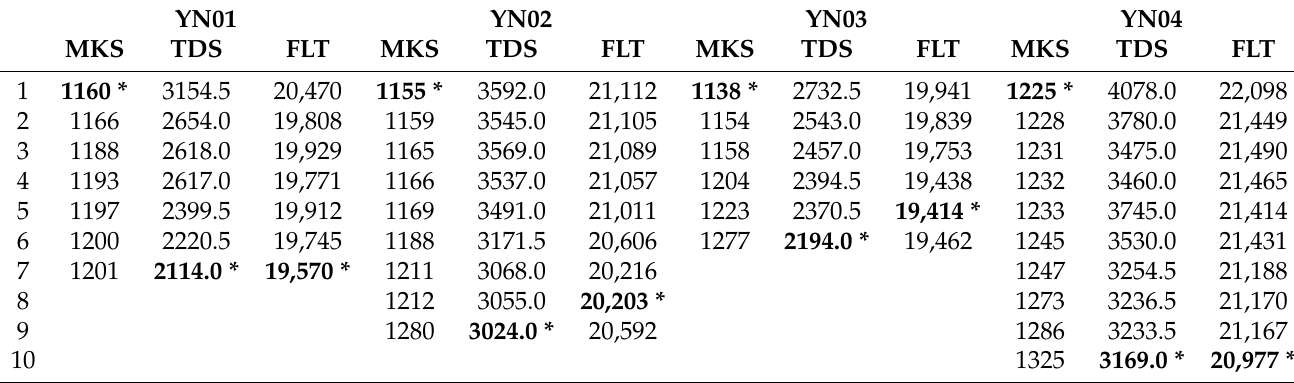
Table A11. Non-dominated front obtained by CMOTA for the JSSP instances proposed by [44].